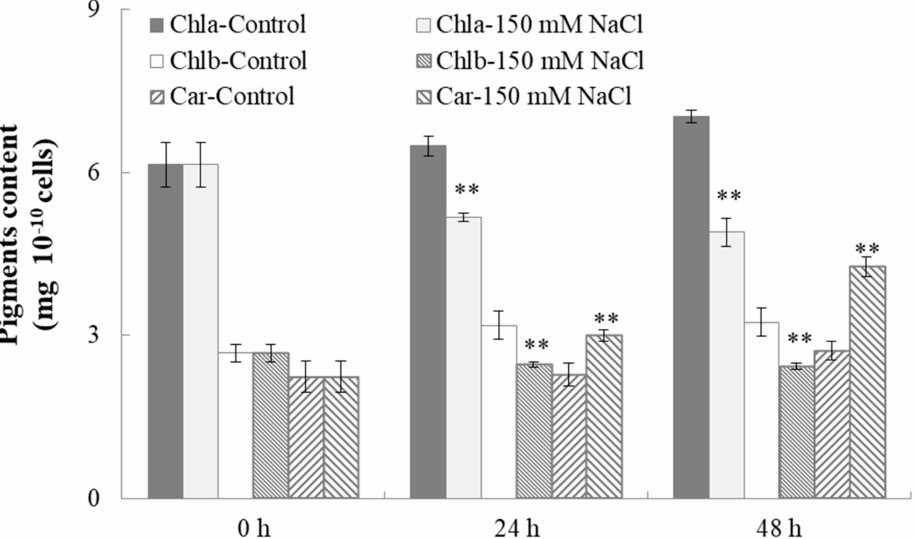
Figure 7. The effect of salt stress on pigment contents of C. reinhardtii . Cell samples harvested after 0, 24, and 48 h cultivation from both the salt treatment and the control were used to measure the contents of chlorophyll a, Chlorophyll b, and carotenoid. Each value is the mean ± SD of three biological replicates. Asterisks indicate statistical significance (* 0.01 < p < 0.05, ** p < 0.01) between control and salt-treated cells according to the Tukey’s